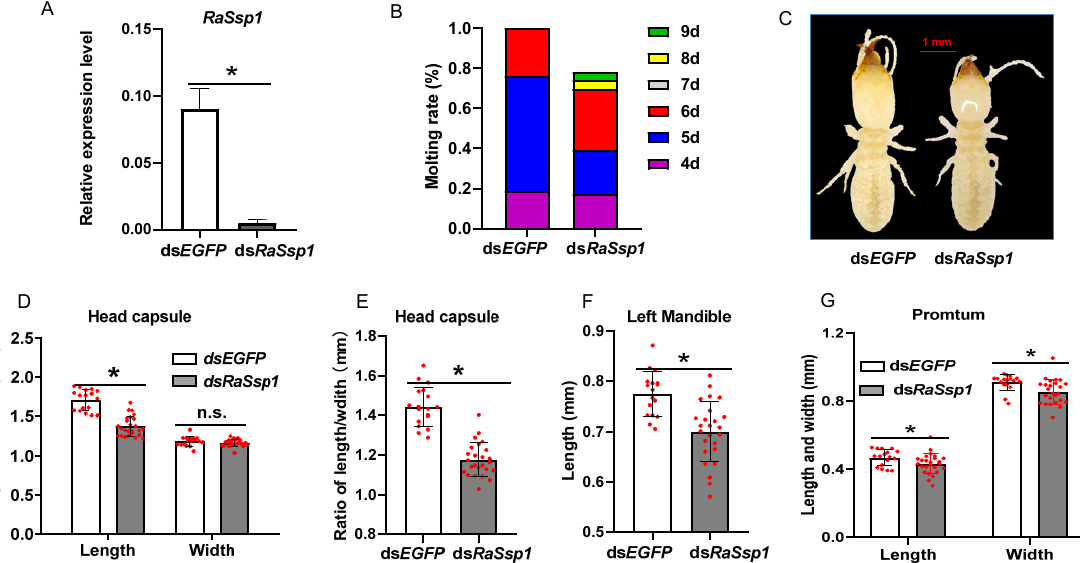
Figure 5. Effects of presoldier RaSsp1 RNAi on soldier differentiation. RaSsp1 dsRNA was injected at the beginning of the gut-purging period in presoldiers, with EGFP dsRNA as control. ( A ) Expression levels of RaSsp1 in the head of presoldiers on the 3rd day after injection of RaSsp1 dsRNA (mean ± S.D., technical triplicates). ( B ) Effect of the 2nd molting ratio after Rassp1 RNAi; 4, 5, 6, 7, 8 and 9 d are the 4th, 5th, 6th, 7th, 8th and 9th days after injection with dsRNA (n = 46). ( C ) Soldier morphology affected by dsRNA injection. Both soldiers were photographed on the 2nd days after the 2nd molt. Scale bar indicates 1 mm. The photos represent the 36 presoldiers. ( D ) The length and width of the head capsule (mean ± S.D., n = 36). ( E ) The ratio of length/width of the head capsule. ( F ) The left mandible length. ( G ) The length and width of the pronotum. Asterisks indicate a significant difference (one-way or two-way ANOVA followed by LSD test using SPSS, * p < 0.05). White and grey columns indicate Rassp1 and EGFP dsRNA-injected individuals,